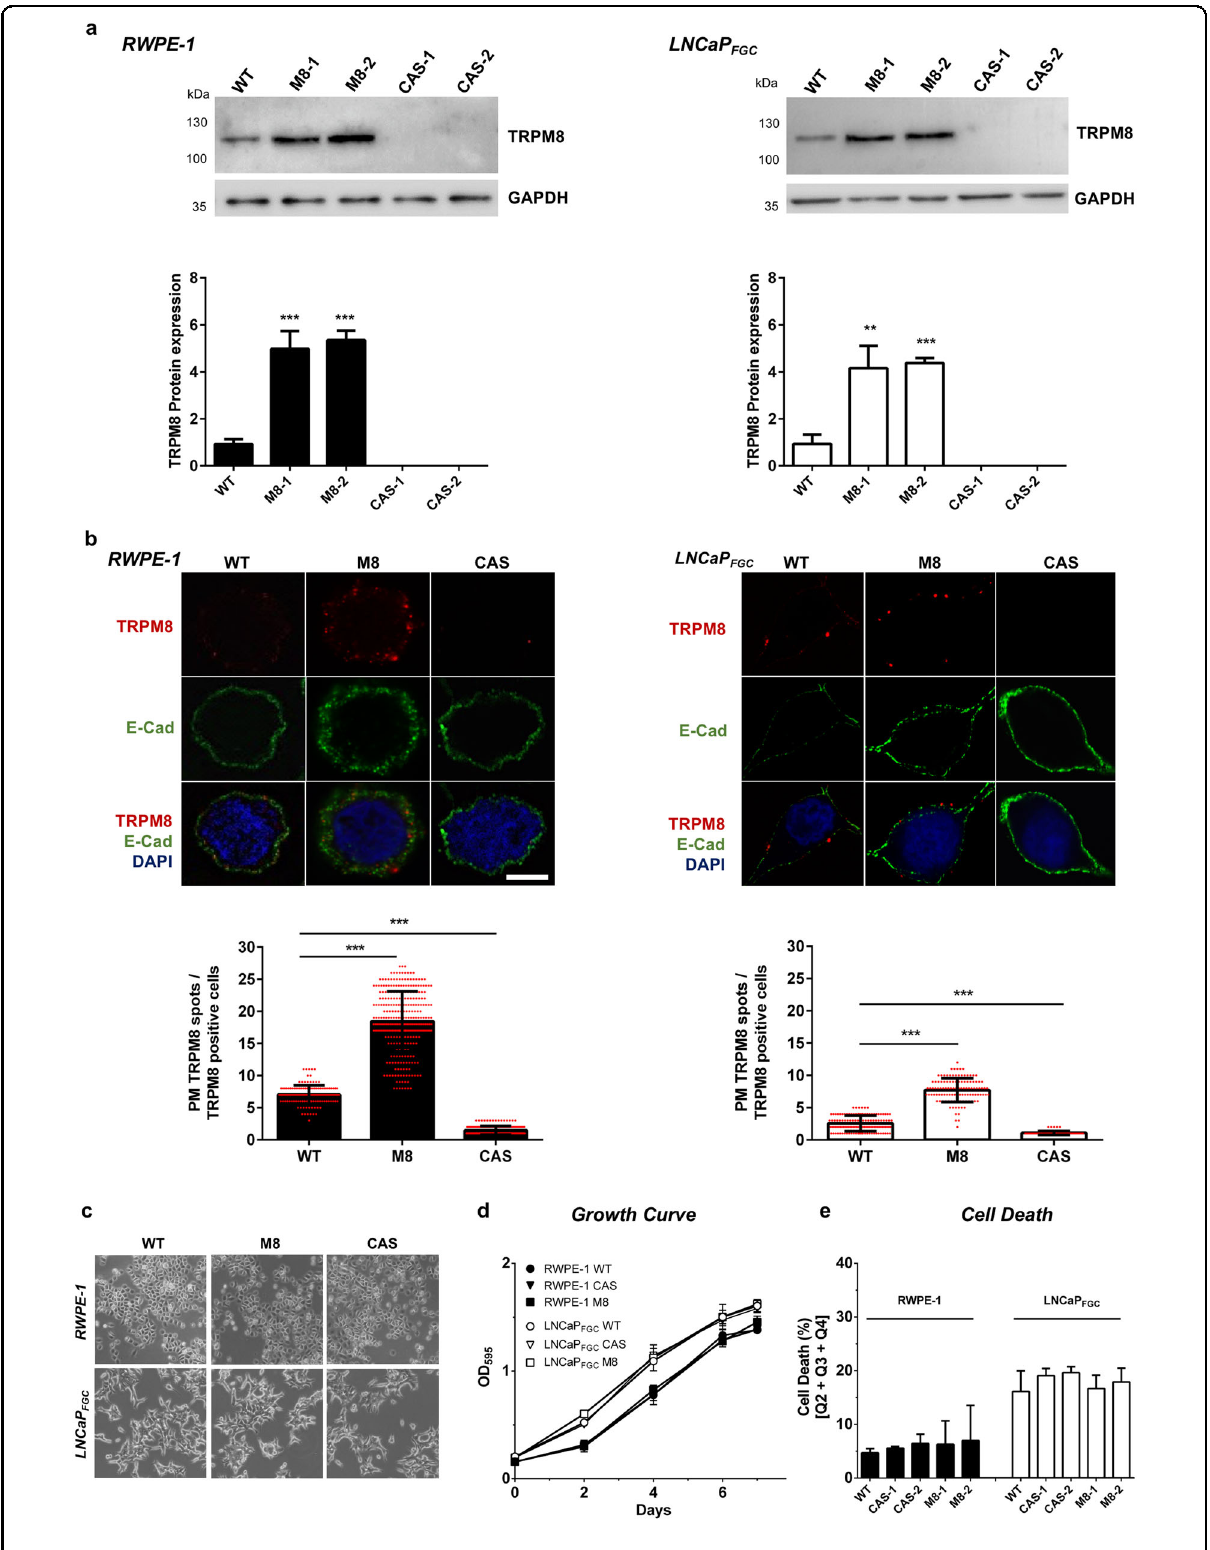
Fig. 2 (See legend on next